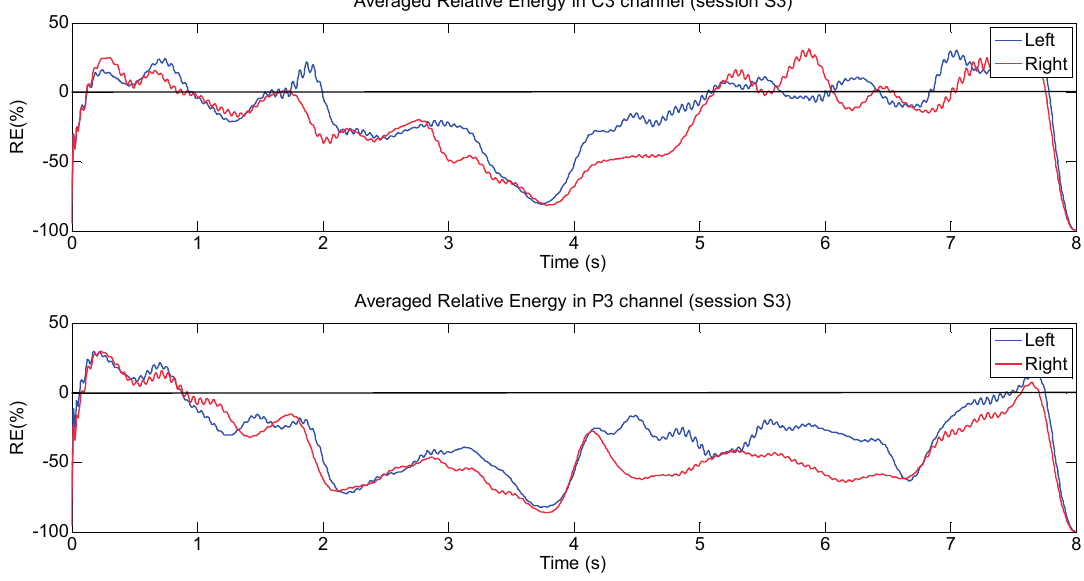
Figure 5. Relative average energy of channels C3 and P3 during S 3 ( μ